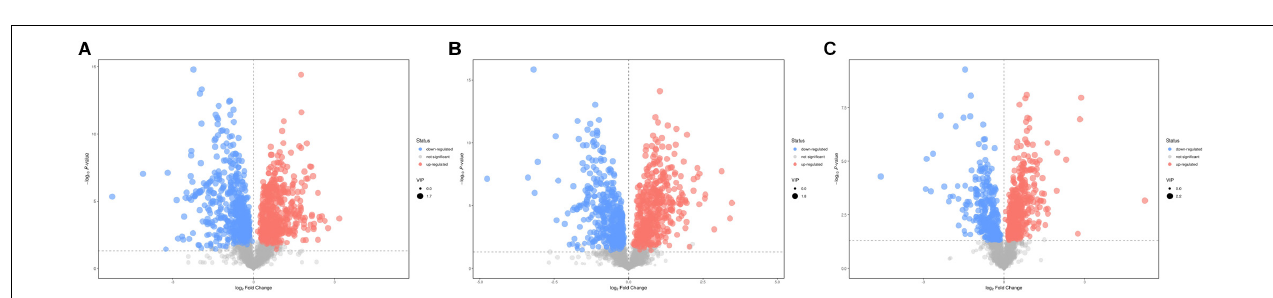
glycine was identified decreased during clonrochiasis. Several amino acids are represented using boxplots in Figure 6 and Supplementary Figure S6